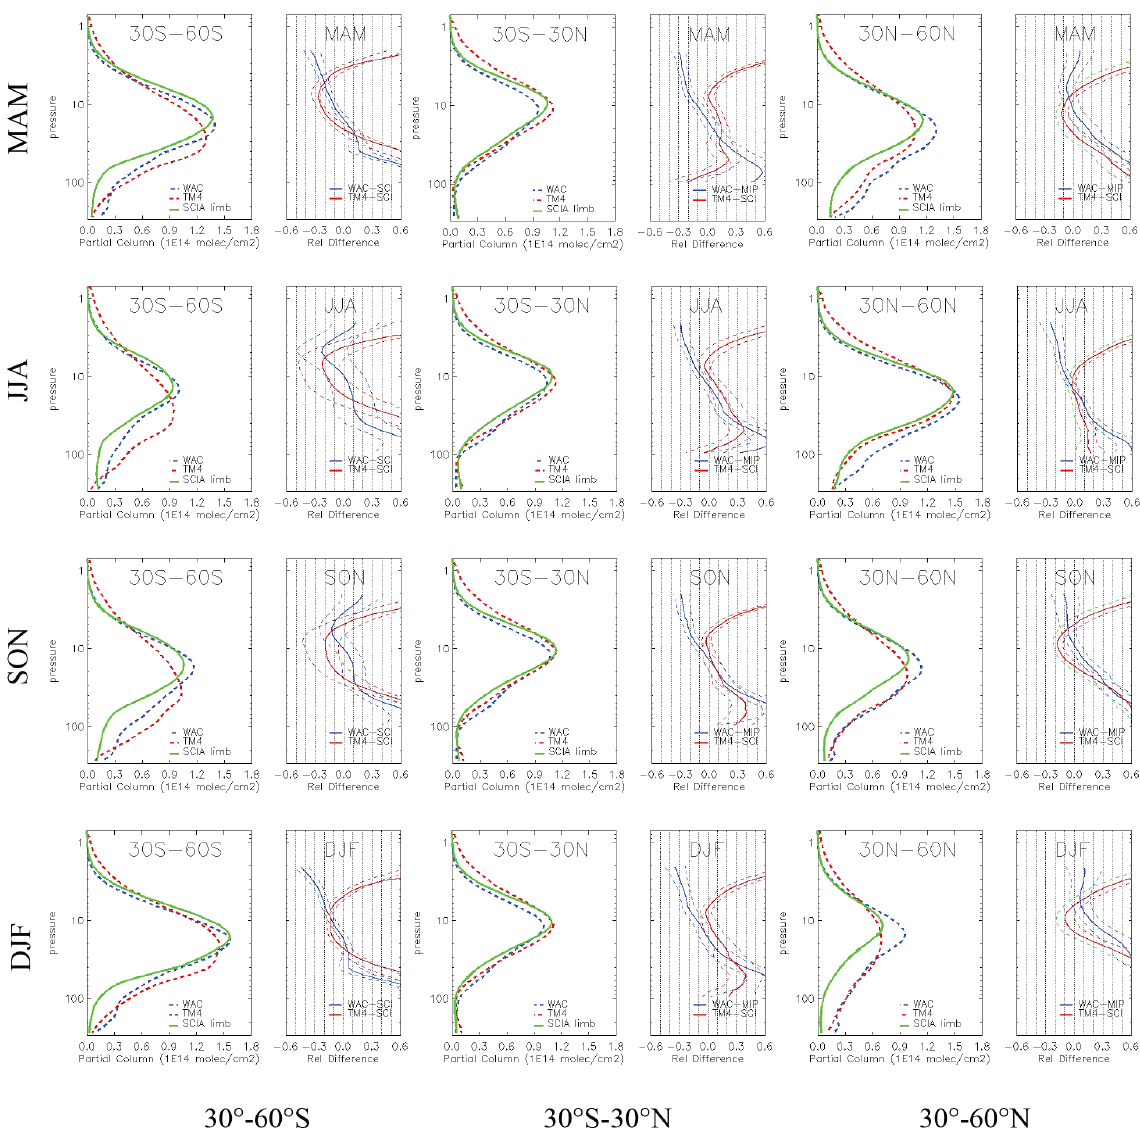
Figure 7. Partial column NO 2 profiles from SCIAMACHY (green), WACCM (dashed blue) and TM4 (dashed red): means and mean relative differences over different latitude sectors (SH in the first column, tropical in the second column and NH in the third column) and seasons (MAM in the first row, JJA in the second row, SON in the third row and DJF in the fourth